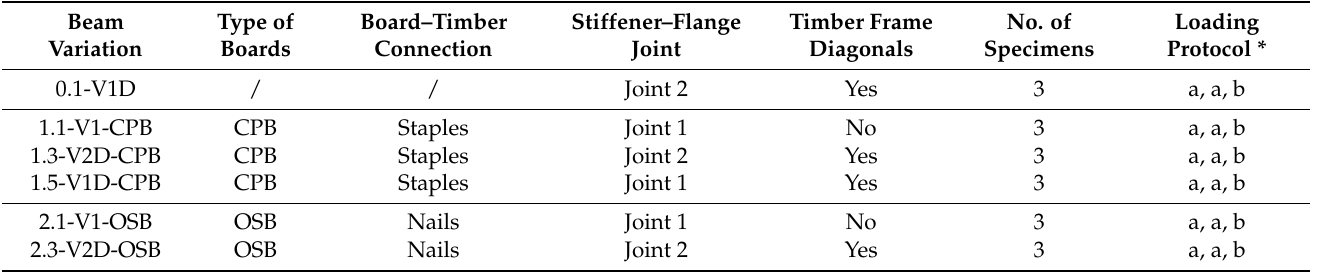
Table 1. Developed and tested composite timber beam variations.